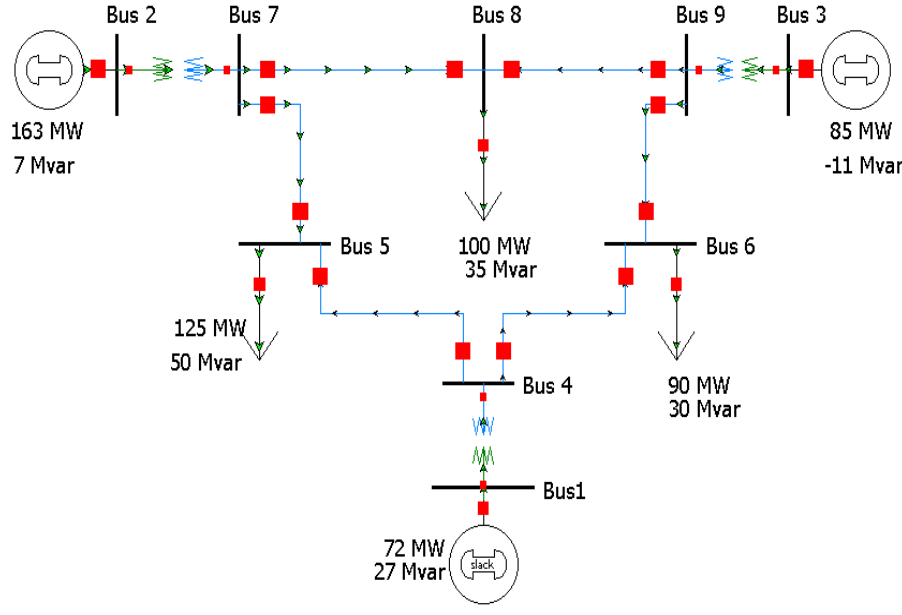
Figure 3. IEEE 9-Bus power